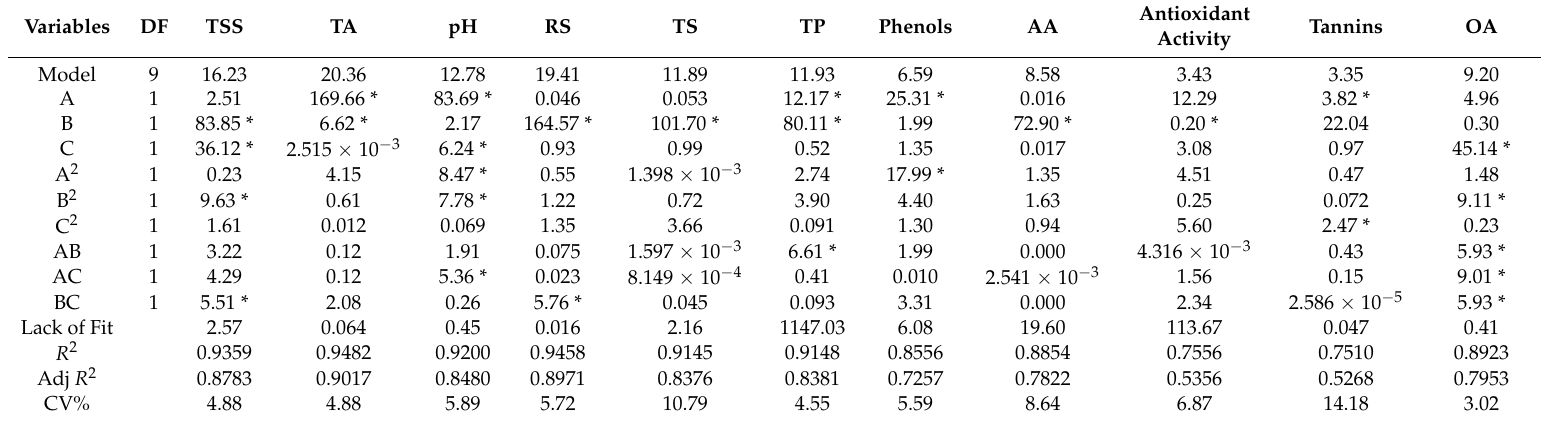
Table 2. ANOVA and regression coefficients of the second-order polynomial model for the response